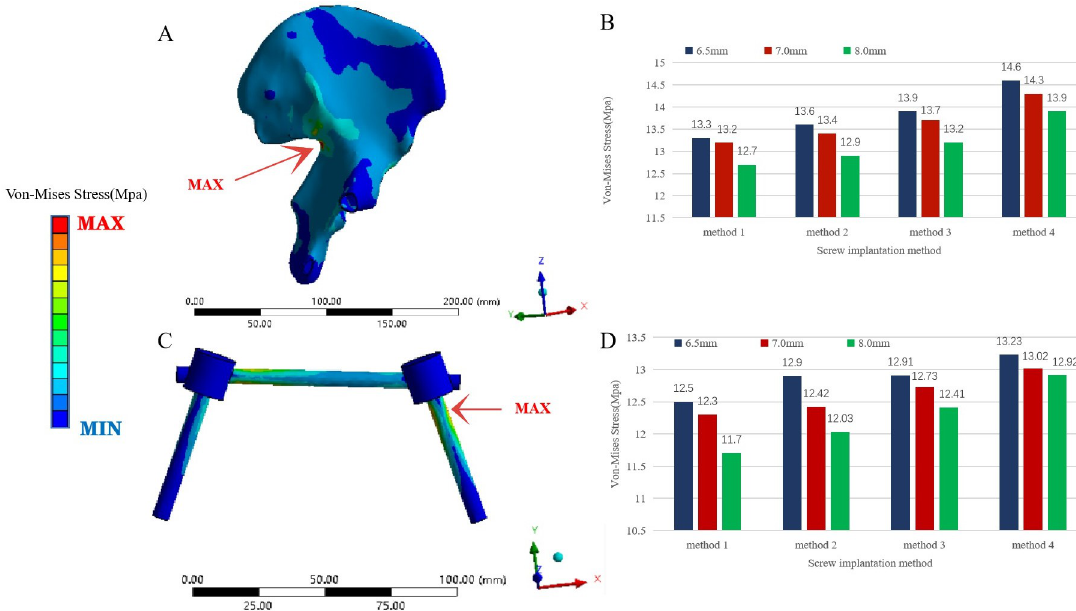
Fig 10. Von Mises stress comparison of pedicle screw fixation models with different diameters and fixation methods. (A) Von-Mises Stress distribution of the iliac bone of the pelvis model fixed with pedicle screws under a vertical load. (B) Comparison of the maximum Von-Mises Stress of the iliac bone of the pelvic model with pedicle screws of three diameters and four fixation methods under a vertical load. (C) Von-Mises Stress distribution of the pedicle screw rod in the posterior ring of the pelvic model fixed with pedicle screws under a vertical load. (D) Comparison of the maximum Von-Mises Stress of the pedicle screw rod in the posterior ring of the pelvic model with pedicle screws of three diameters and four fixation methods under a vertical load.